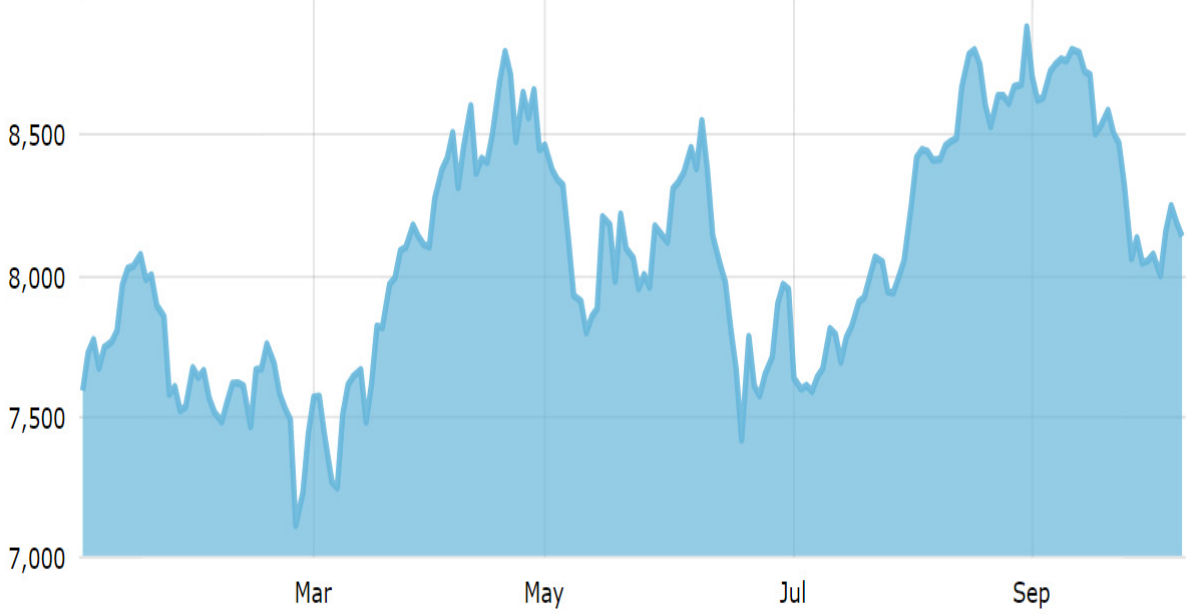
Figure 6. S&P BSE Energy Index Performance January 2022–October 2022. Source: https://www.bseindia.com/sensex/code/90 (accessed on 24 August 2022) [17].